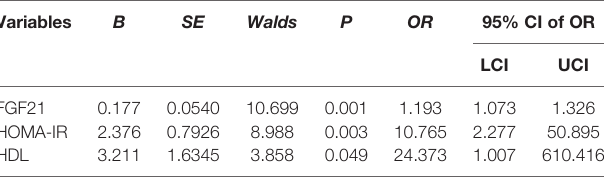
TABLE 4 | Logistic regression analysis on the determinants of erectile function in human study. Variables